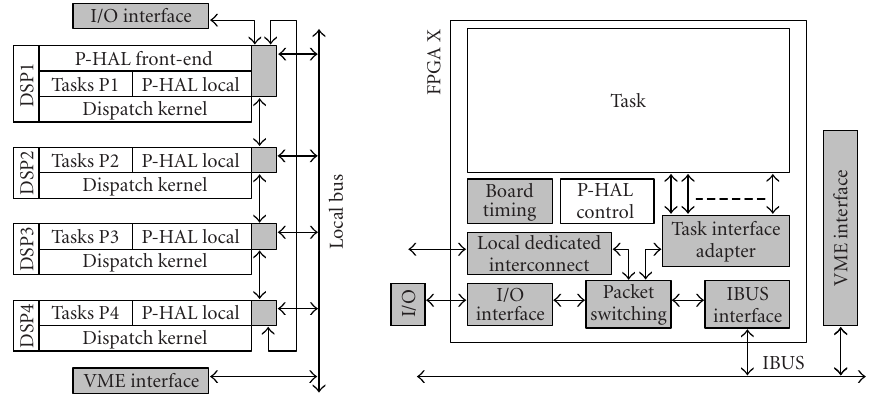
Figure 5: DSP board P-HAL software and single FPGA P-HAL